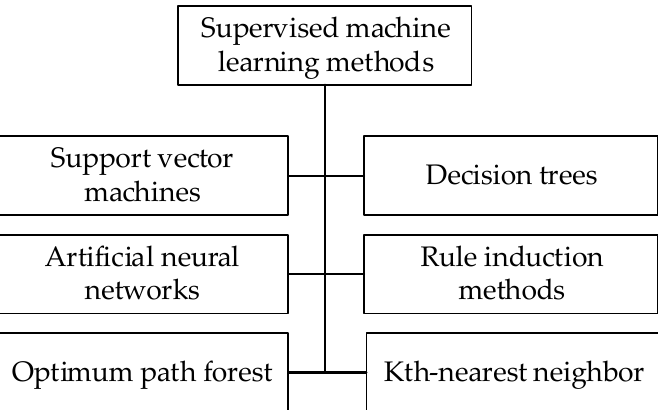
Figure 2. Supervised machine learning methods.